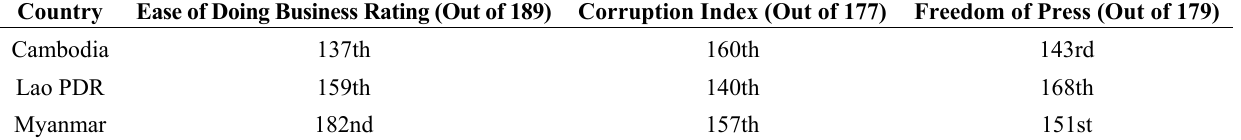
Table 2. An overview of three international indices where China is heavily investing in hydropower in the